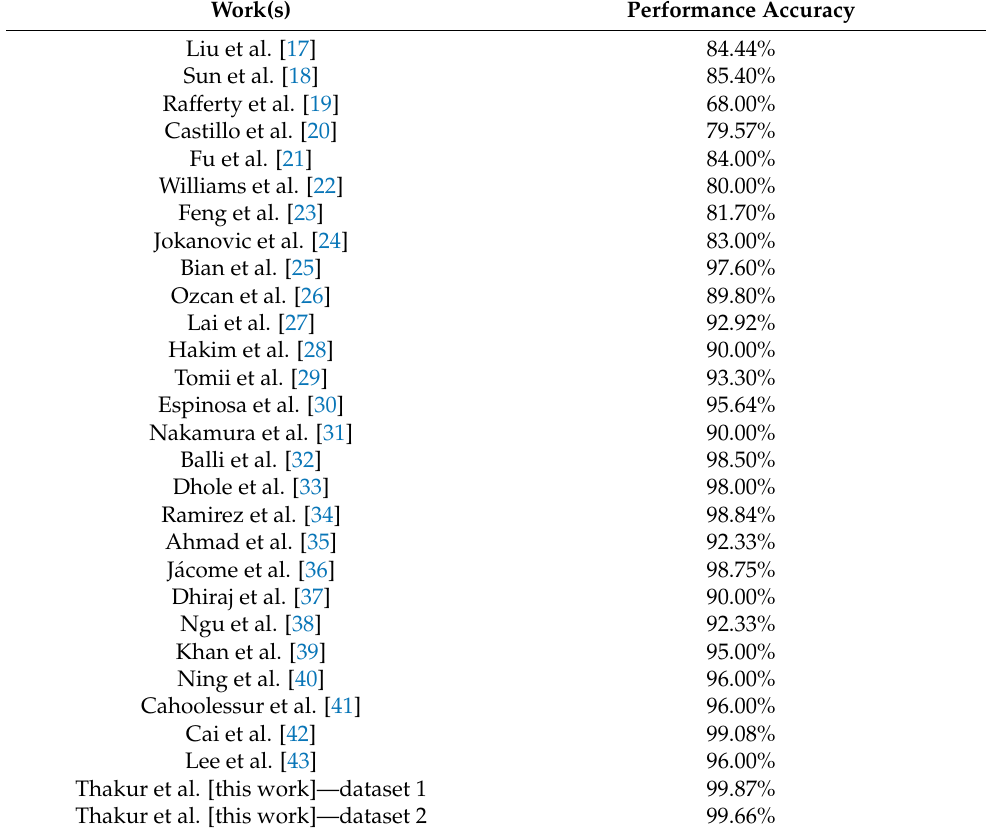
Table 5. Summary of recent works in fall detection along with their performance